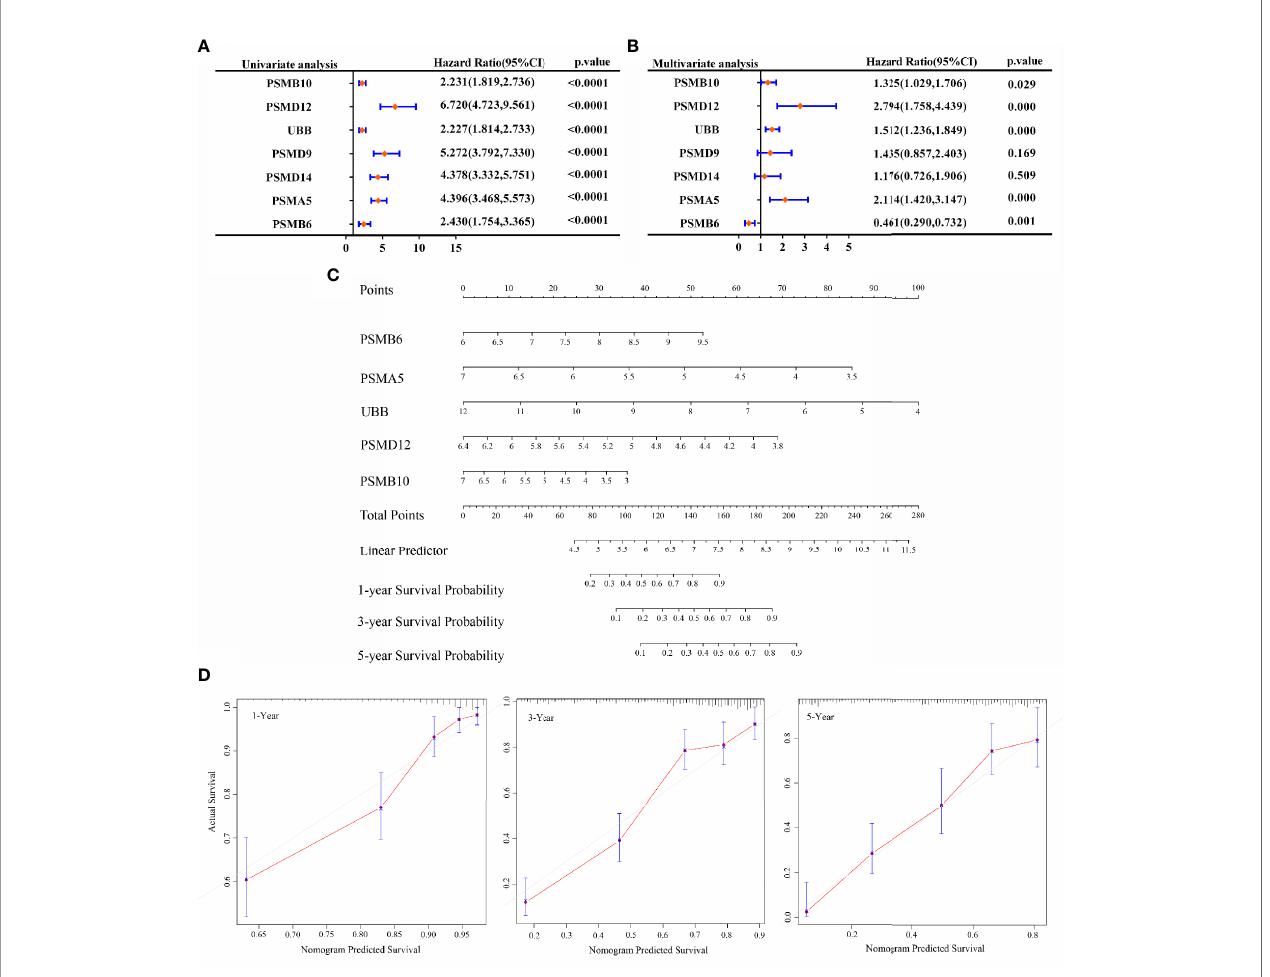
FIGURE 6 | Prognosis prediction by Cox analysis of seven gene signatures. (A) p-value, risk factor HR, and con fi dence interval for single-factor Cox analysis of seven gene signature expressions and clinical characteristics. (B) p-value, risk factor HR, and con fi dence interval for multifactor Cox analysis of seven gene signature expressions and clinical characteristics. (C) Column line graphs predicting overall survival at 1, 3, and 5 years for glioma patients. (D) Calibration curves of the overall survival column line graph